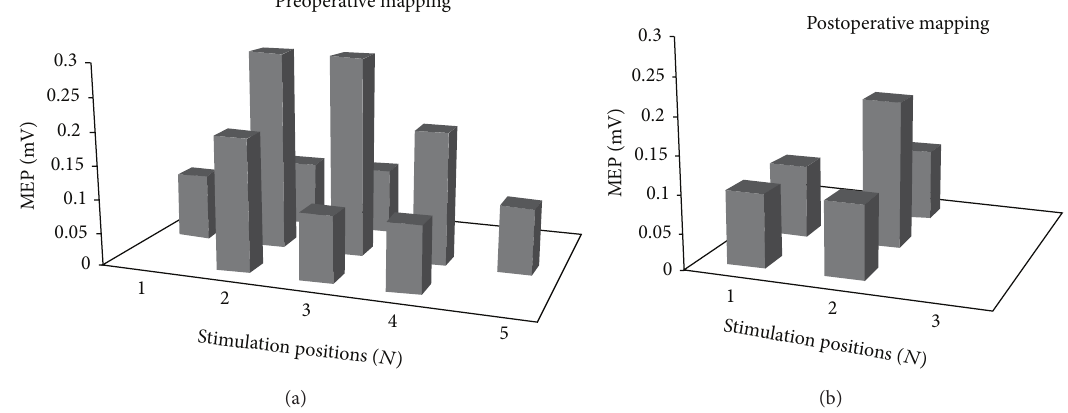
Figure 3: Schematic diagram depicting motor output mapping of a patient in Group A. In the preoperative grid, sMEP is 1.7 mV as sum total of 10 stimulation positions eliciting an MEP ( 𝑁 = 10 ). Postoperatively, sMEP was reduced to 0.7 mV and 𝑁 to 5. sMEP, sum of MEP amplitudes in